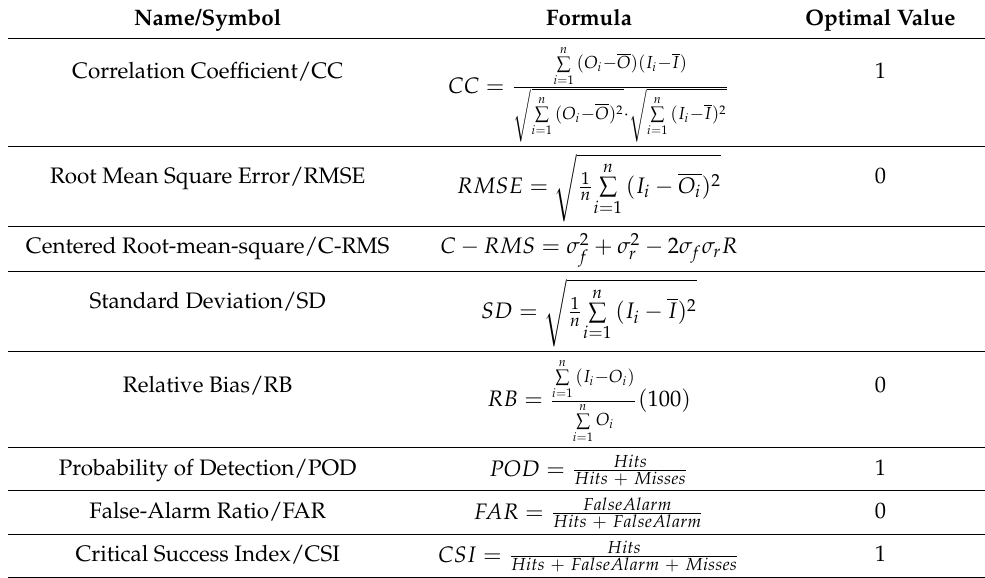
Table 1. Statistical